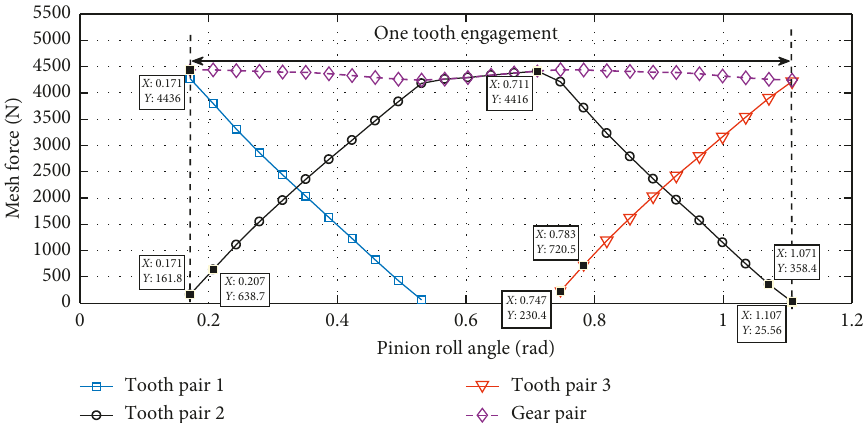
Figure 9: Finite element calculation of the effective mesh force of the tooth pair and the net mesh force of the gear pair over one tooth engagement cycle.